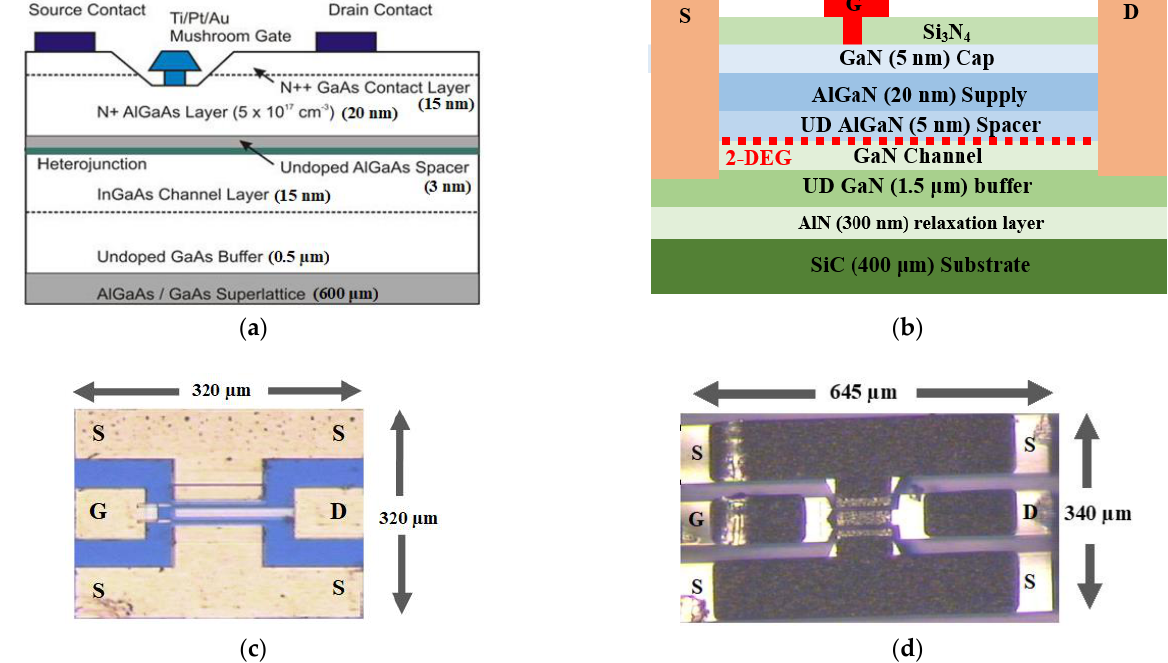
Figure 1. Schematic cross-sectional views and photos of the tested high electron-mobility transistors (HEMTs) based on ( a , c ) AlGaAs/GaAs and ( b , d ) AlGaN/GaN heterostructures.